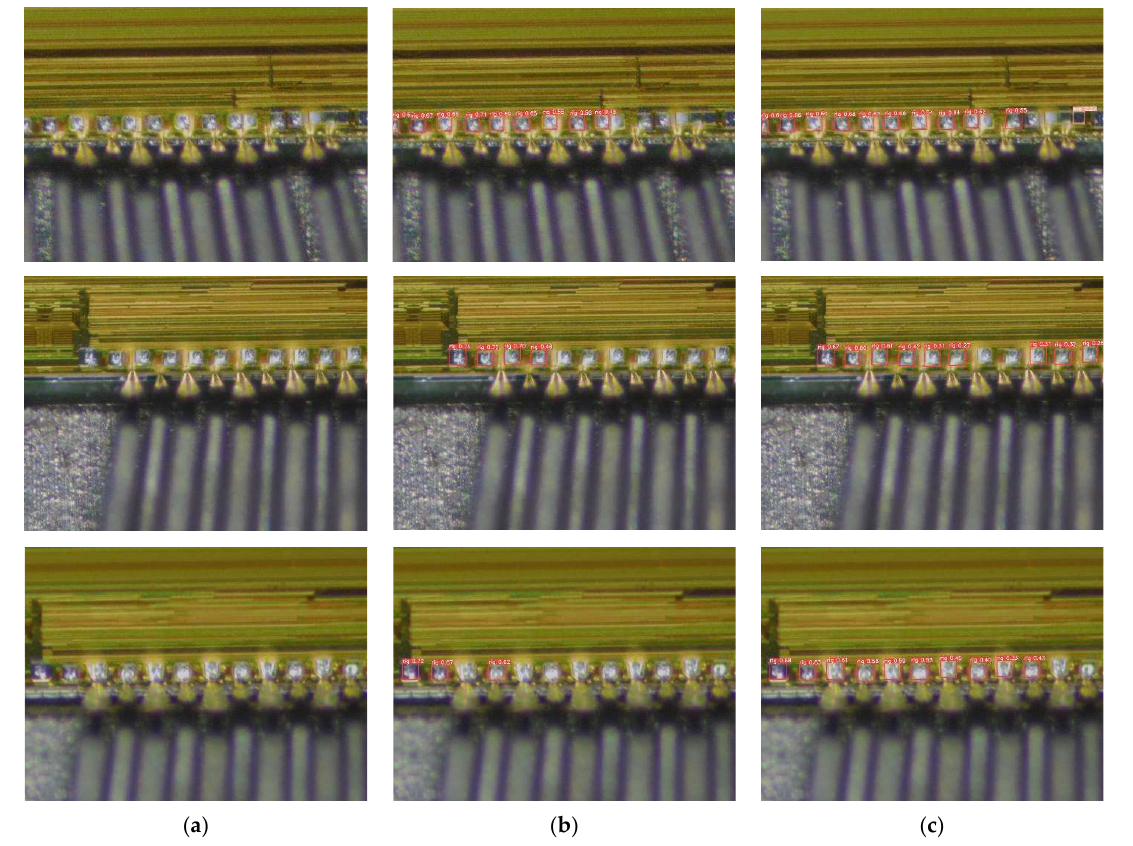
Figure 9. ( a , b ) Our method.